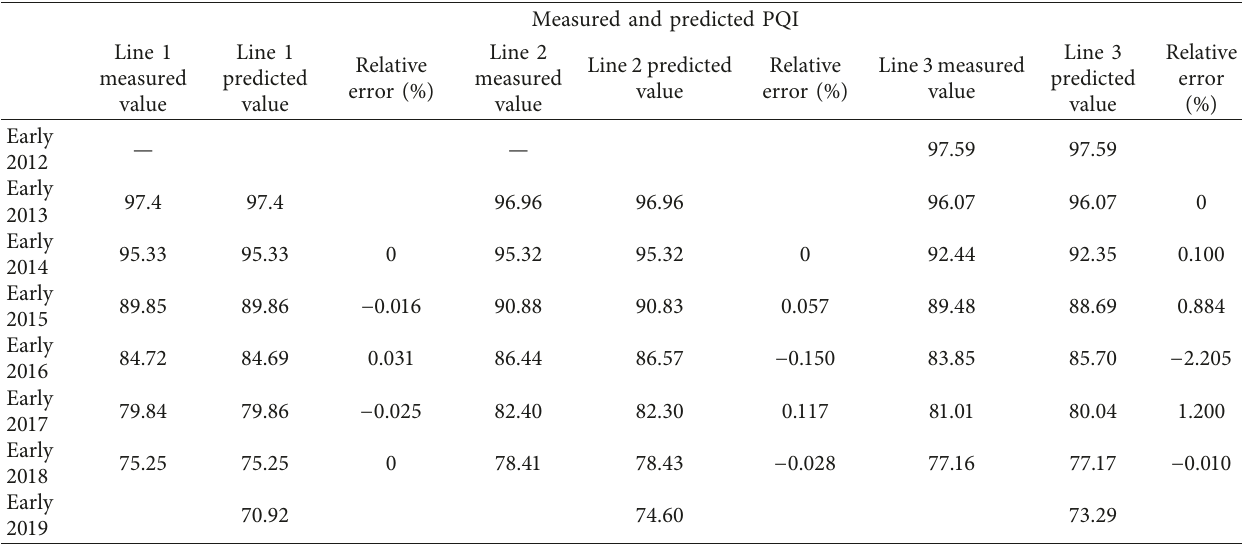
Table 12: Measured and predicted PQI for three typical roads of the trunk highway in Hunan Province.